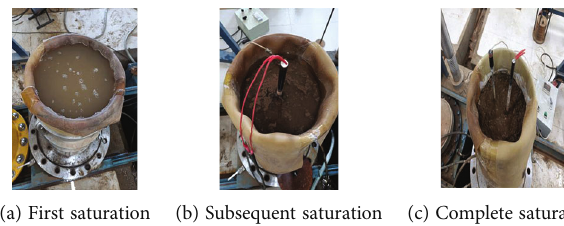
Figure 3: Sample saturation.